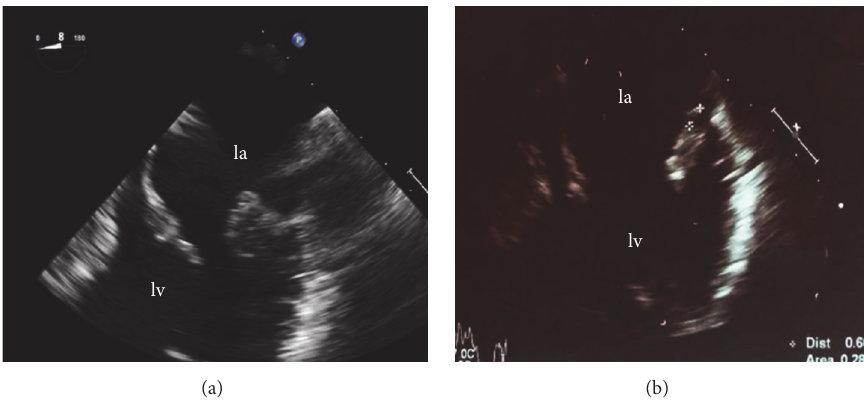
Figure 2: TOE 4 chambers: the admission of TOE on (a) shows a vegetation on the posterior leaflet of mitral valve. The follow-up TOE (b) confirmed the persisting of the vegetation of reduced dimensions, compared with the previous exam (a), despite clinical